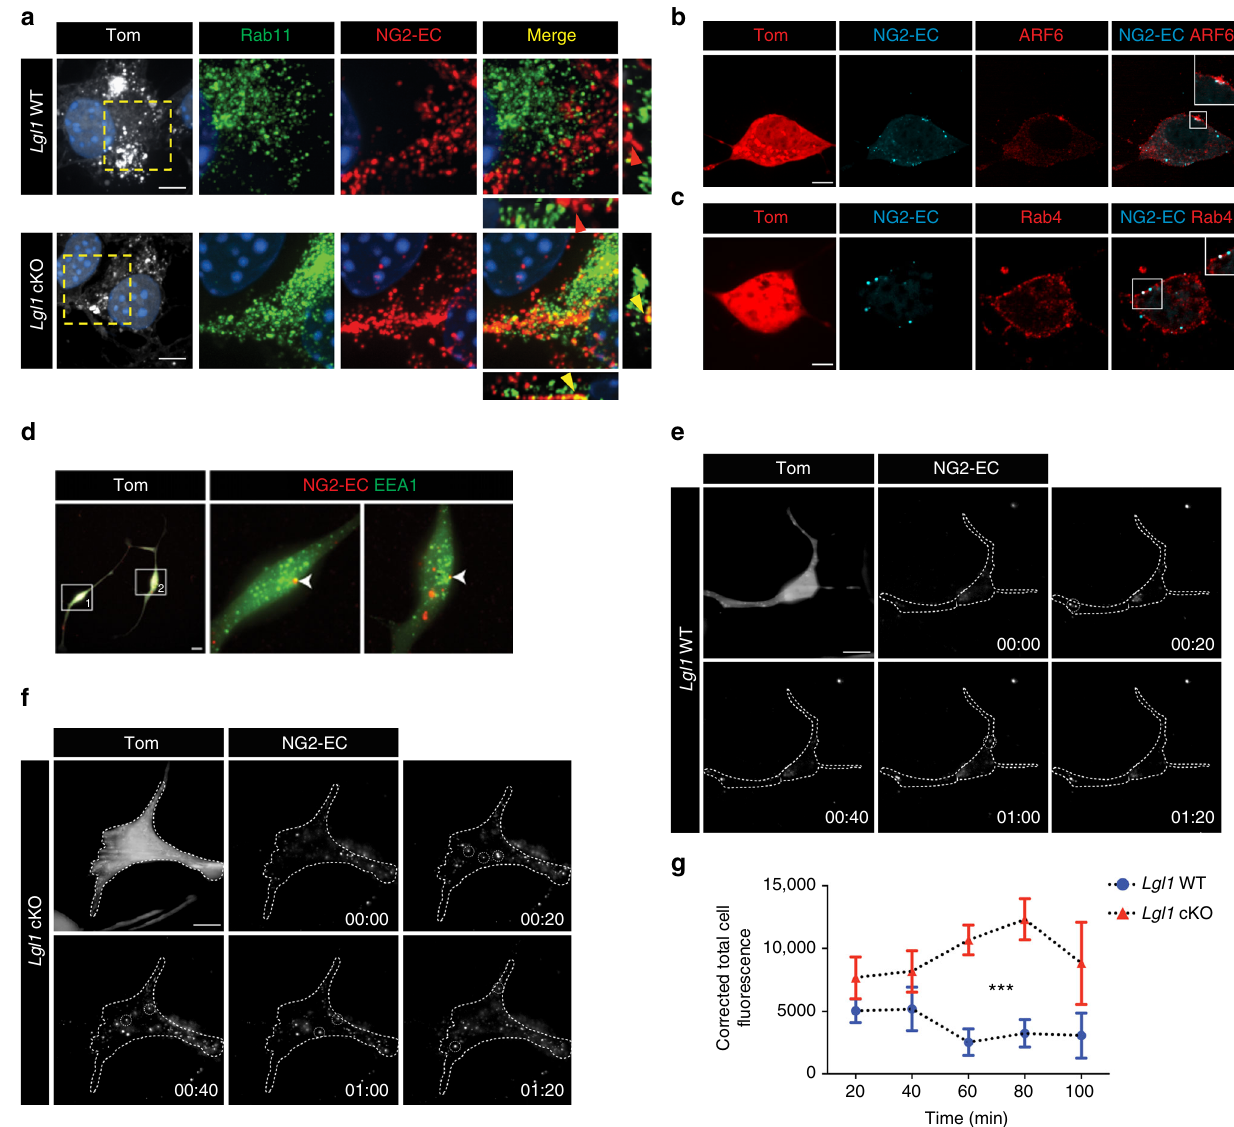
Fig. 6 Non-degraded NG2 in Lgl1 cKO OPC is recycled to the membrane. a Representative co-immunostaining for NG2-EC (red) and Rab11 (green) 45 min after incubation in differentiation medium. Note the higher colocalization of NG2-EC with Rab11 in Lgl1 cKO OPC (yellow arrowheads) compared to Lgl1 WT cells (red arrowhead). Scale bar: 5 μ m. b – d Fluorescent immunostaining pictures illustrating colocalization of remaining NG2 (blue) with ( b ) ARF6 (red), ( c ) Rab4 (red), and ( d ) EEA1 (green) in Lgl1 cKO cells 24 hours after incubation in differentiation conditions. Scale bars: 10 μ m. e , f Frames illustrating TIRF time lapse of Lgl1 cKO and WT cells 4 hours after incubation in differentiation conditions. Pictures were taken each 20 min. Examples of recycling labeled NG2 puncta (white) are highlighted in dashed circle. NG2 recycling persists in Lgl1 cKO cells up to time point 01:20 whereas it is insigni fi cant in WT cells. Time indicated as hours:minutes. Scale bar: 10 μ m. g Graph representing quanti fi cation of the corrected total cell fl uorescence re fl ecting NG2 recycling in Lgl1 cKO cells (blue circles) and in Lgl1 WT cells (red lozenges). Data are depicted as mean ± s.e.m., n = 8 cells for each genotype, three independent experiments (*** p < 0.01, two-way